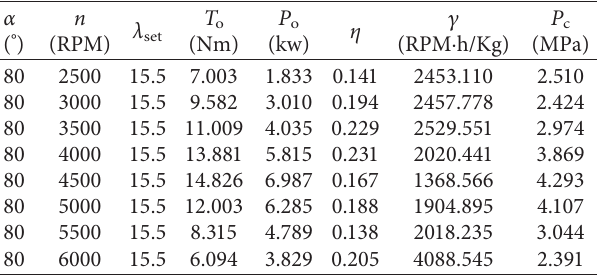
Table 4: Results of the GT-power simulation when α � 80 °